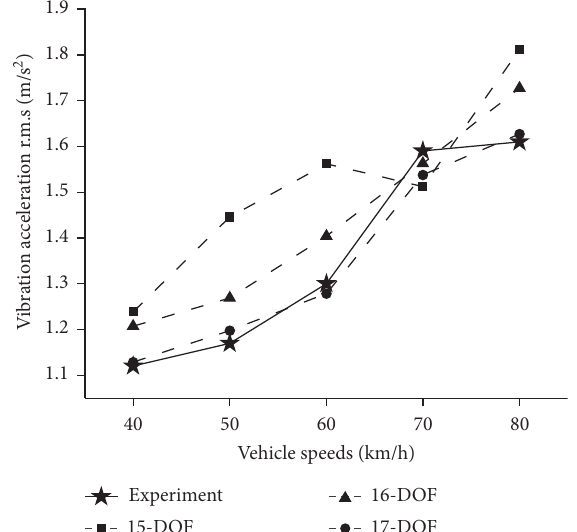
Figure 6: Comparisons of the vibration acceleration r.m.s. at different vehicle speeds between experimental and simulation results.